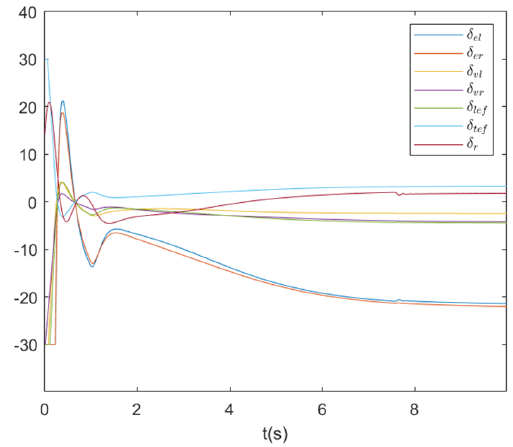
Figure 9. Actuator actions of Fighter 3.